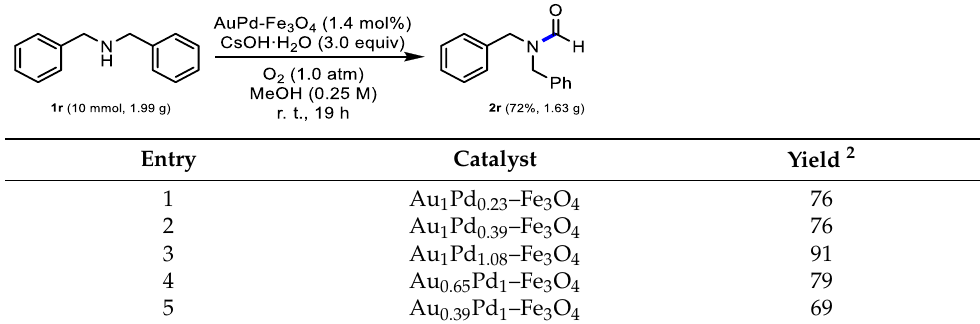
Scheme 6. Gram scale reaction.